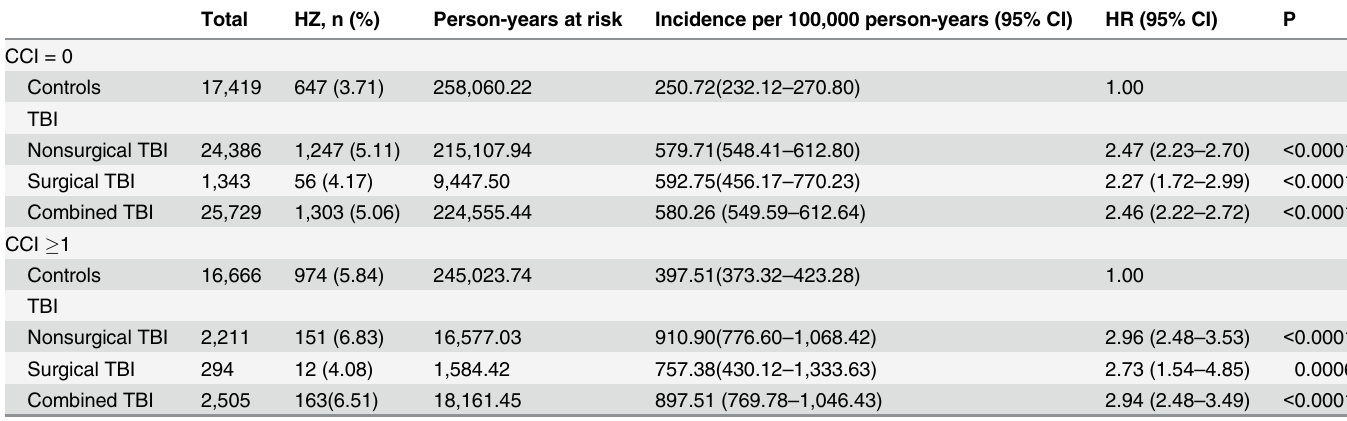
Table 4. Incidence and hazard ratios for herpes zoster during the follow-up period for adult patients with traumatic brain injury versus control co- horts with a Charlson comorbidity index = 0 or (cid:1)